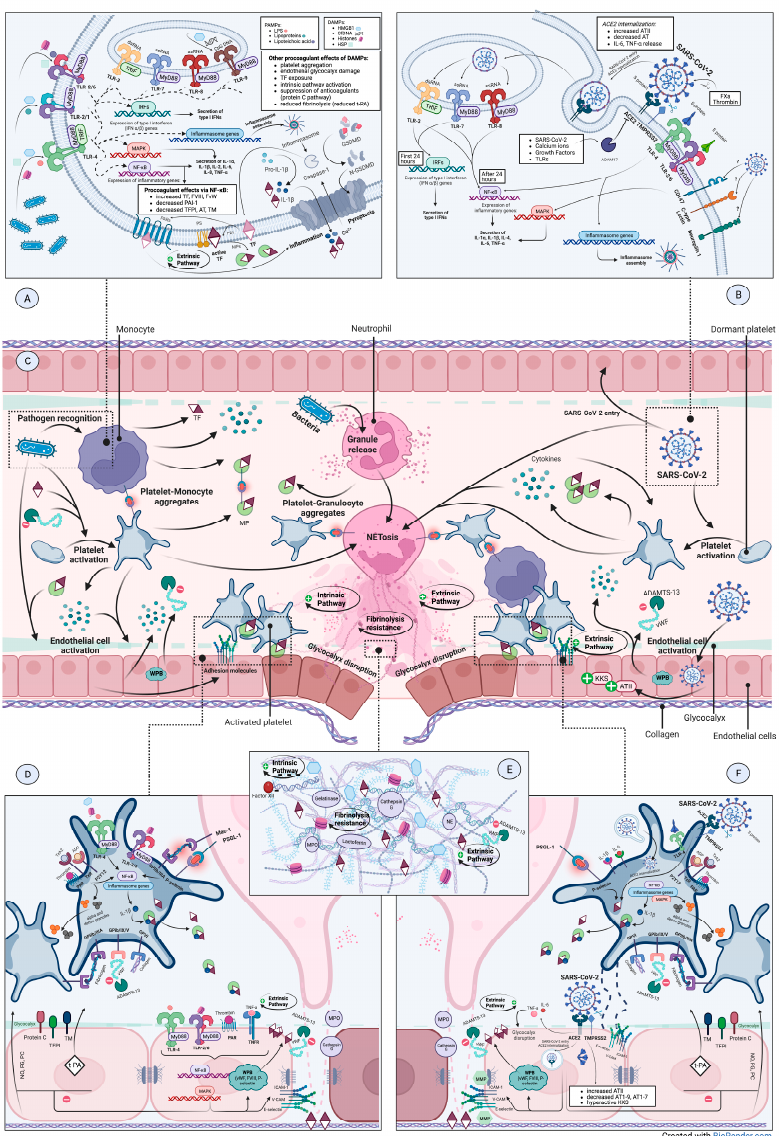
Figure 1. A comparative overview of pathogenic mechanisms involved in sepsis-induced coag- ulopathy and COVID-19-associated coagulopathy. ( A ). Pathogen recognition pathways in bacterial sepsis. ( B ). Molecular mechanisms of SARS-CoV-2 entry and subsequent cell injury. ( C ). Intravascular inter- play of pathogens (i.e., bacteria and SARS-CoV-2), effector cells and humoral factors in the context of sepsis-induced coagulopathy versus COVID-19-associated coagulopathy. ( D ) . Platelet and en- dothelium dysfunctions in bacterial sepsis. ( E ). NETs components and NET-associated prothrombotic status. ( F ). Platelet and endothelium dysfunctions in COVID-19. Abbreviations: ACE2, angiotensin- converting enzyme 2; ADAM17, a disintegrin and metalloprotease 17; ADAMTS13, a disintegrin and metalloprotease with a thrombospondin type 1 motif, member 13; ADP, adenosine diphosphate; AT, antithrombin; ATII/1-9/1-7, angiotensin II/1-9/1-7; CD147, cluster of differentiation 147; Cf/CpG DNA, cell-free/cytosine-guanine pair desoxyribonucleic acid; CLR, C-type lectin receptor; DAMP, damage-associated molecular pattern; FVIII/X/XII, coagulation factor VIII/X/XII; GP-Iba-IX-V, glycoprotein Iba-IX-V; GPIIb/IIIa, glycoprotein IIb/IIIa; GPVI, glycoprotein VI; GSDMD, Gasdermin D; HMGB1, high mobility group box 1; Hsp, heat-shock proteins; ICAM-1, intercellular adhesion molecule 1, IFN, interferon; IL, interleukin; IRF, interferon-regulatory factor; KKS, kallikrein-kinin system; LPS, lipopolysaccharides; Mac-1, macrophage 1 antigen; MAPK, mitogen-activated protein kinase; MMP, matrix metalloprotease; MP, microparticle; MPO, myeloperoxidase; MyD88,